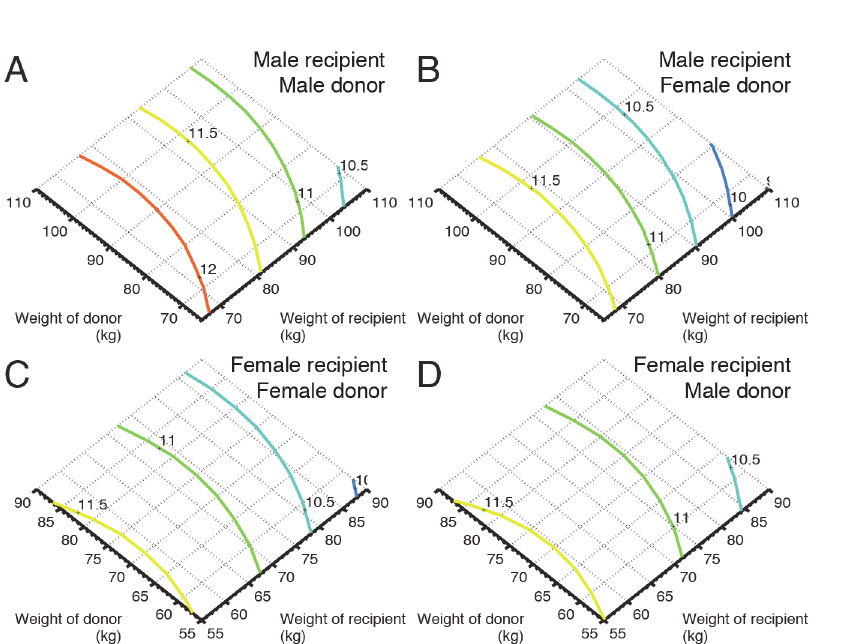
Fig 4. Influence of weight and gender match. Panel (A) illustrates, in matched cohorts, the influence of donor weight and recipient weight on survival for male-male donor-recipient pairs, and panels B, C, and D illustrate the influence on survival for female-male, female-female, and male-female donor-recipient pairs, respectively. The colored solid lines show the predicted survival in years (dark blue: worst; dark red: